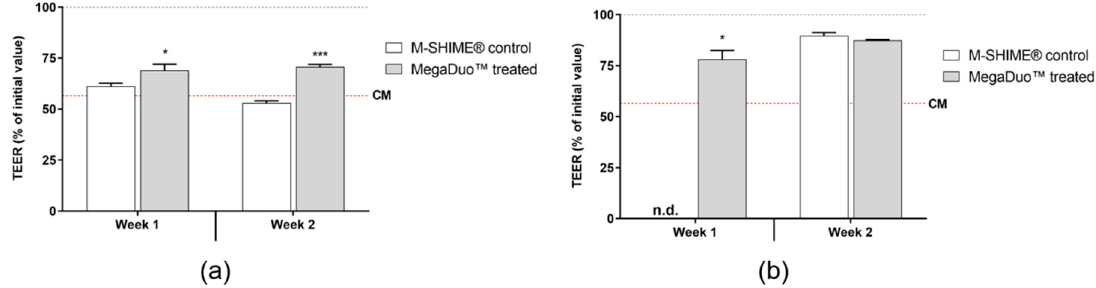
Figure 5. Barrier integrity of Caco-2 cells after exposure to M-SHIME ® suspensions ( a ) with or ( b ) without pre-treatment with clindamycin. * p ≤ 0.05, *** p ≤ 0.001, grey dashed line = 100% TEER, red dashed line = TEER (% of initial value) for co-cultures treated with CM. Error bars represent standard error of the mean. CM = Caco-2 media; M-SHIME ® = mucosal simulator of the human intestinal microbial ecosystem; TEER = transepithelial electric resistance.